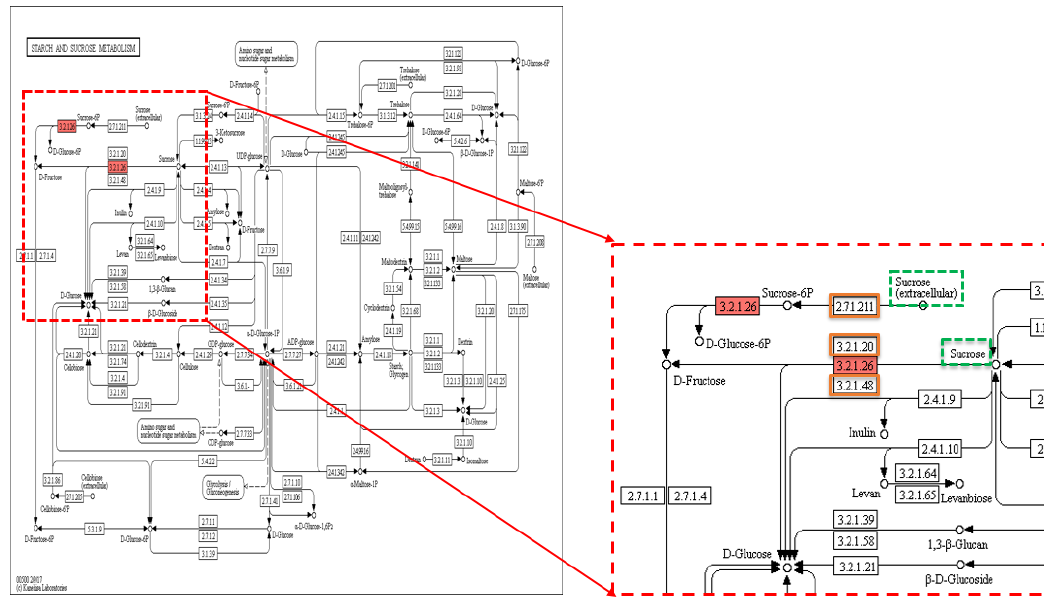
Figure 4. KEGG pathway of starch and sucrose metabolism showing sucrose metabolism. KEGG pathway of starch and sucrose metabolism showing sucrose metabolism (invertase catalyses sucrose into fructose and glucose) (dotted red box), dotted green squares: substrates including sucrose, solid red square: 3.2.1.26 -invertase enzyme encoded by GIF1 (grain incomplete filling) (LOC4335790) gene carrying the TAVs identified in this study, and orange squares: other enzymes involved in the pathway. Reprinted with permission from Kyoto Encyclopedia of Genes and Genomes (KEGG), http://www.kegg.jp/kegg/kegg1.html.